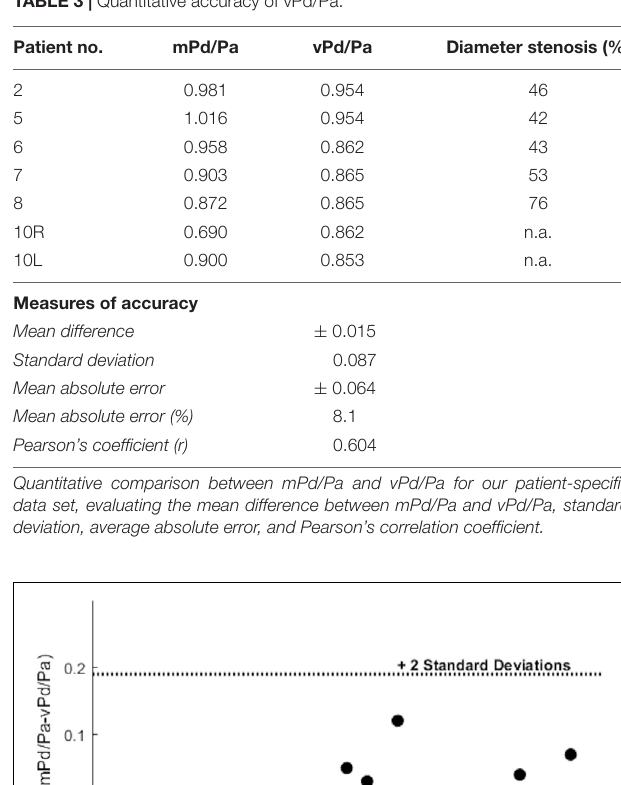
TABLE 3 | Quantitative accuracy of vPd/Pa.